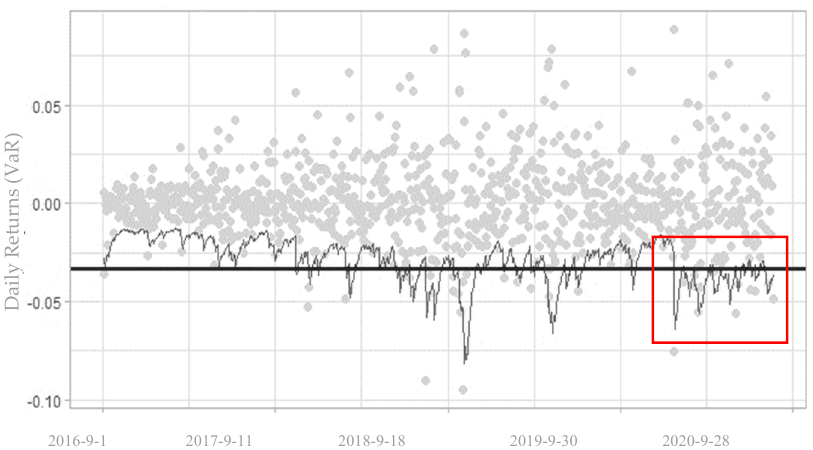
Figure 2. VaR Value of Daily Returns of the Stock Index in the Airport Shipping Set (31 August 2016–1 September 2020) Note: 1. The fluctuant curve is the VaR outcome of the GARCH model, while the thick black line is the VaR outcome of the normal distribution; 2. The red box represents the volatility of daily returns of ASSI during the COVID-19 period.